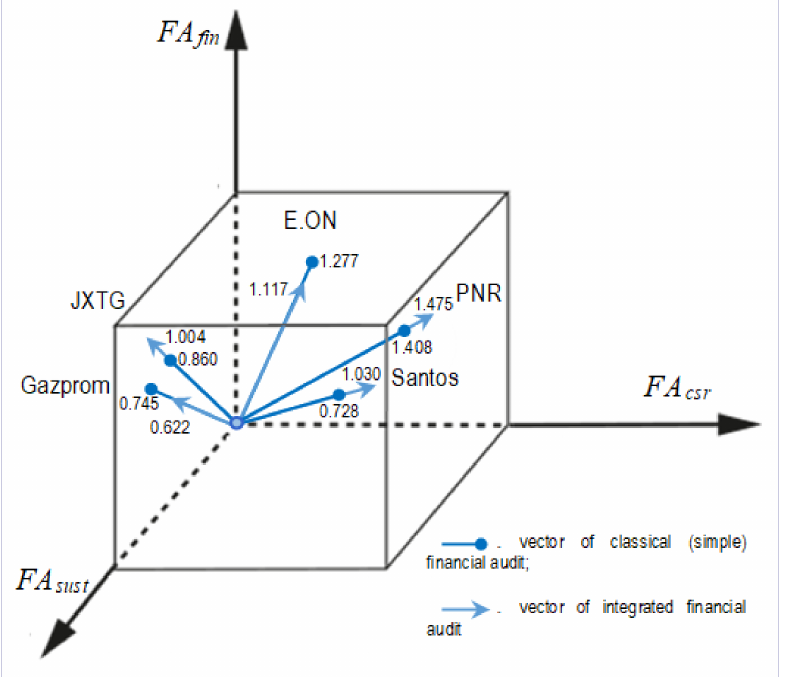
Figure4. Vectorsofthefinancialauditinthecontextoftheperformanceofcompanies,